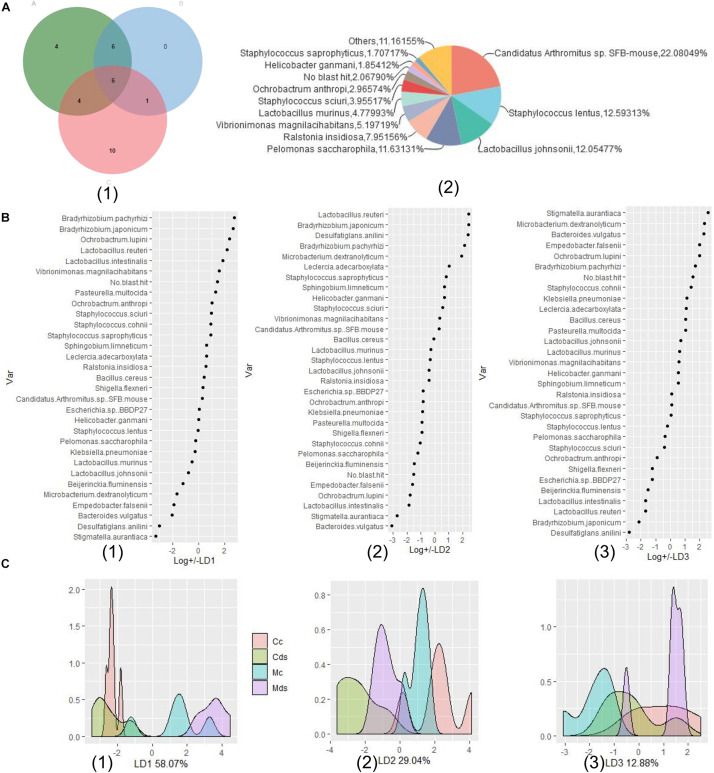
Relative abundance of microbiota-based machine-learning model based on LDA (linear discriminant analysis). (A) Identification of the signature gut microbiota, associated with repeated stress-related diarrhea. (1) To detect signature bacterial markers in response to the repeated stress-related diarrhea, we performed comparison of differences between groups (in green A), LEfSe analysis (in blue B), and relative abundance analysis (in red C) to identify the 31 key bacterial species in response to repeated stress-related diarrhea in the discovery phase. (2) The proportion of relative abundance of the 31 key bacterial species. (B) The relevance of each bacteria in the predictive model was assessed using learning LDA machine-learning classifier in the relative abundance of the 31 key bacterial species, and there are three LDA models, LD1 (1), LD2 (2), and LD3 (3), which can make good classification according to the relative abundance of bacteria. (C) A mathematical model based on the 31 key bacterial species was used to predict the sampling group. (1) Density distribution of samples on the LD1 model (58.07%); (2) density distribution of samples on the LD2 model (29.04%); (3) density distribution of samples on the LD3 model (12.88%).